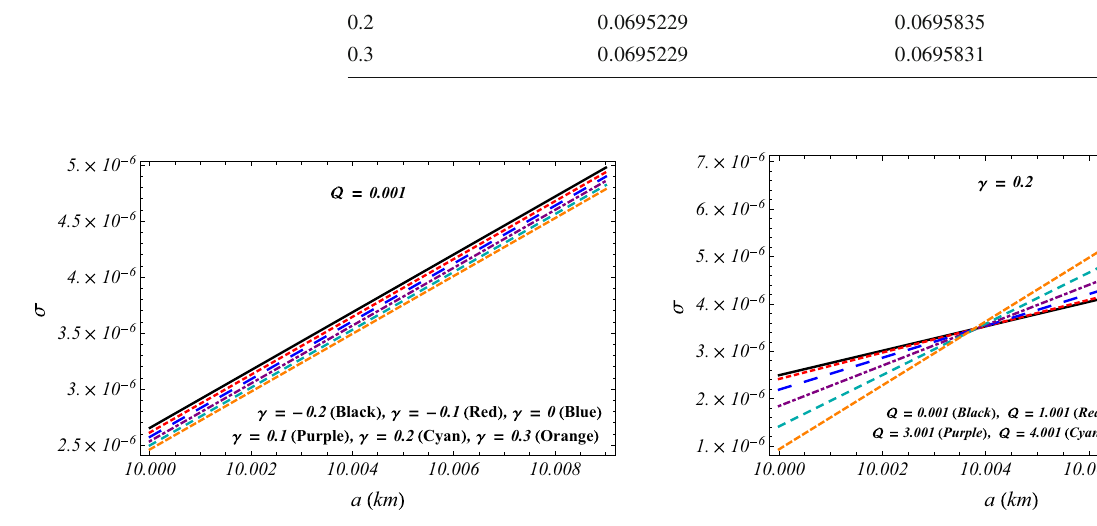
Table 1 The numerical values of the constants C 2 , A and D have been presented for different values of the coupling constant γ for the compact star with M = 1 . 75 M (cid:11) , r 1 = 10 km, r 2 = 10 . 009 km, Q = 0 . 001